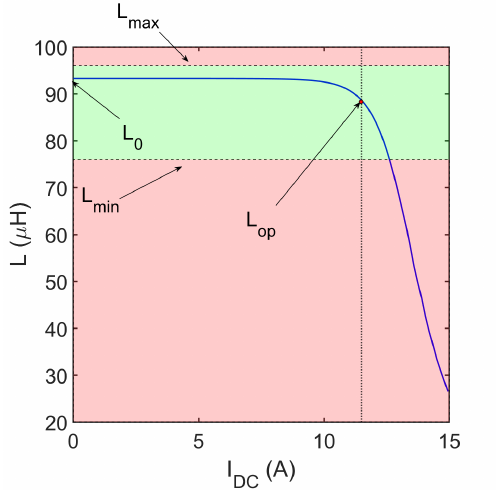
Figure 3. Differential inductance profile of a design configuration as a function of the output current of the converter. The bandwidth of the admissible inductance value is highlighted in green. The proposed case represents a solution operating in partial